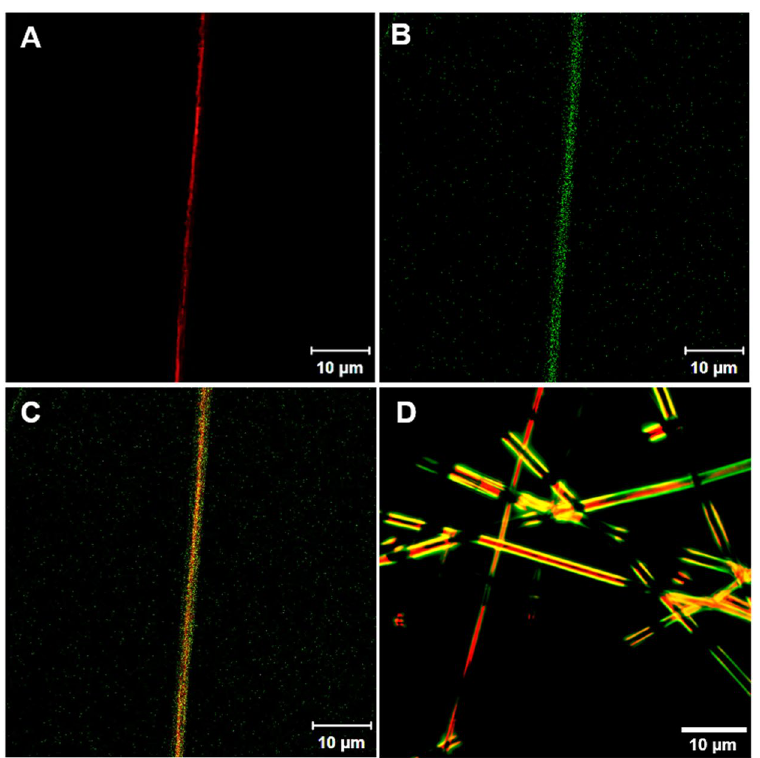
Figure 2. Microscope images of coaxial electrospun fibers. ( A – C ) Confocal images of coaxial fibers with RhodamineBSA shown red fluorescence in the core ( A ) and FITC-BSA shown green fluorescence in the shell ( B ) respectively, and the merged image ( C ). ( D ) Phase contrast merged image showed the distribution of proteins in the core-shell structures with red fluorescence RhodamineBSA in core and green fluorescence FITC- BSA in